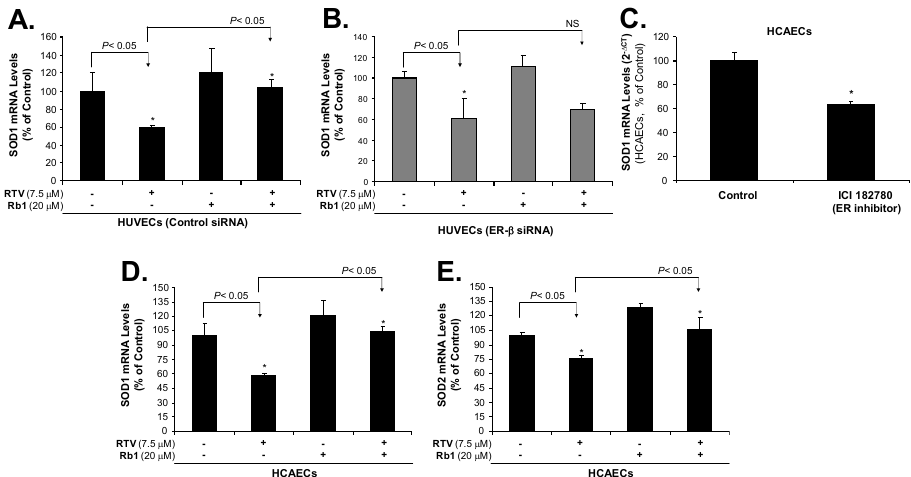
Figure 4. Effect of ER-β silencing, ritonavir (RTV), and ginsenoside Rb1 on the mRNA levels of SOD1 and SOD2 (real time PCR). ( A ) RTV treatment decreased SOD1 mRNA levels, and ginsenoside Rb1 effectively blocked this effect of RTV in HUVECs with control siRNA; ( B ) RTV treatment decreased SOD1 mRNA levels, while Rb1 did not block RTV-induced reduction of SOD1 mRNA levels in HUVECs in which ER-β had been silenced; ( C ) HCAECs were treated with ER inhibitor ICI 182780 (10 -6 M) or DMSO (negative control) for 24 h, SOD1 mRNA levels were decreased in the ICI-treated group compared with control group, showing a critical role of ER on the maintenance of SOD1 levels; ( D ) RTV treatment decreased SOD1 mRNA levels, and ginsenoside Rb1 effectively blocked this effect of RTV in HCAECs; ( E ) RTV treatment decreased SOD2 mRNA levels, and ginsenoside Rb1 effectively blocked this effect of RTV in HCAECs. Student’s t -test was used to compare the control with the treated groups or between two groups. n = 3, * p < 0.05. Similarly, the treatment with RTV significantly reduced eNOS protein and mRNA levels in both HUVECs and HCAECs as compared with negative controls ( p < 0.05, Figure 5). Furthermore, HUVECs treated with RTV showed a significant reduction in eNOS mRNA levels, and co-treatment with 20 μM Rb1 restored eNOS expression (Figure 6). However, the effect of RTV was not blocked by Rb1 in HUVECs treated with ER-β siRNA, indicating that ER-β is involved in the gene regulation by Rb1.